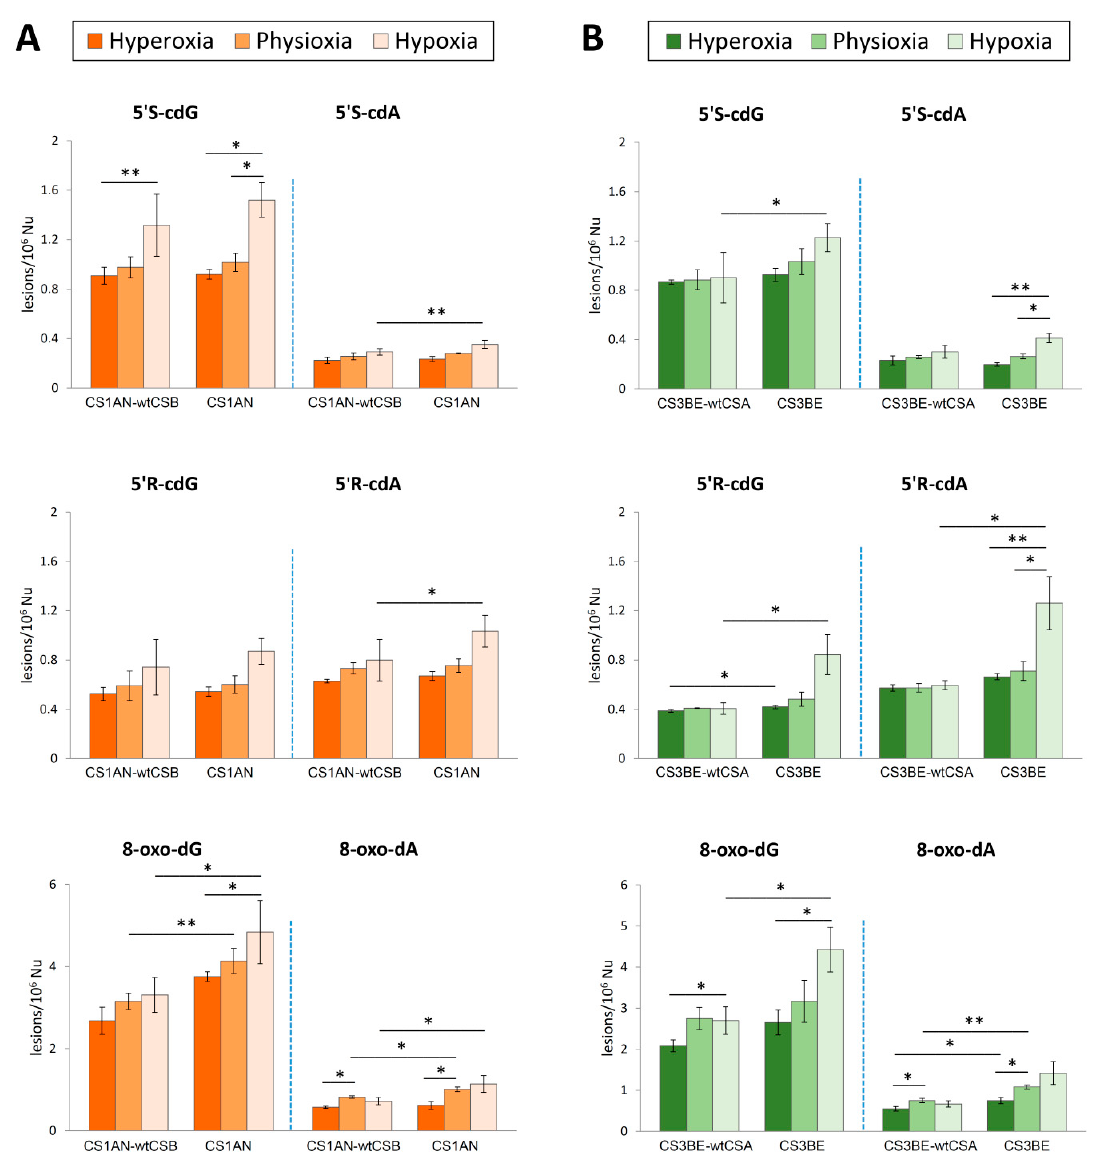
Figure 1. The levels (lesions/10 6 Nu) of 5 ′ S -cdG, 5 ′ S -cdA, 5 ′ R -cdG, 5 ′ R -cdA, 8-oxo-dG and 8-oxo-dA measures by LC-MS/MS. ( A ) Purine DNA lesions in DNA samples isolated from CS1AN-wtCSB and CS1AN cells in hyperoxic, physioxic and hypoxic conditions (cf. Tables S2 and S4 for details). ( B ) Purine DNA lesions in DNA samples isolated from CS3BE-wtCSA and CS3BE cells in hyperoxic, physioxic and hypoxic conditions (cf. Tables S3 and S5 for details). The error bars represent the standard deviation of the mean, calculated from three independent samples, * denotes a statistically significant difference ( p < 0.05) between the groups, ** denotes a statistically significant difference ( p < 0.01) between the groups.